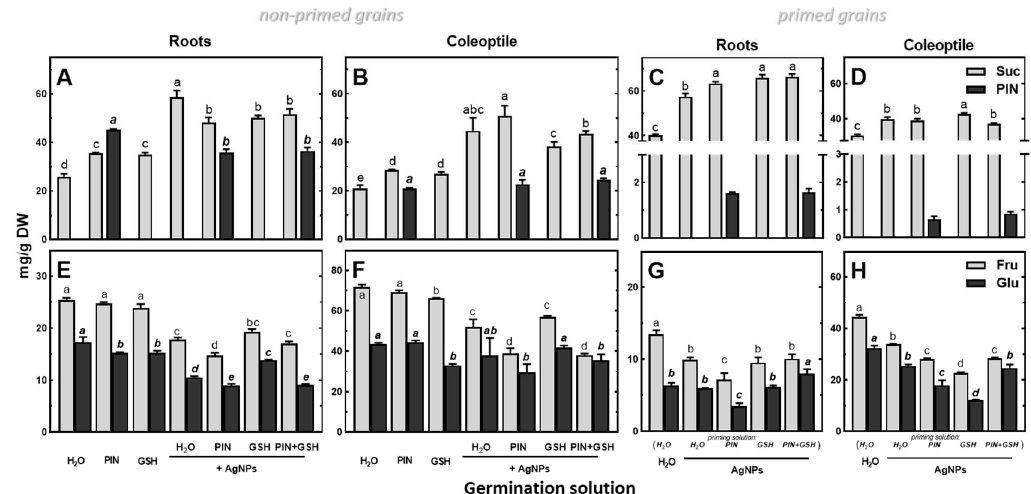
Figure 9. The effects of PIN (50 mM), GSH (12.5 mg/L), (Bio)Ag NPs (at 40 mg/L) and their mixtures on the concentrations of sucrose ( Suc ), D -pinitol (PIN), fructose ( Fru ) and glucose ( Glu ) in roots ( A , C , E , G ) and coleoptiles ( B , D , F , H ) in 3-day-old seedlings of wheat ( Triticum aestivum L. cv. Collada) obtained from non-primed ( A , B , E , F ) and primed grains ( C , D , G , H ). Values are means ( n = 3) + SD. Bars with the same letters (a–e) were not significantly ( p < 0.05) different after ANOVA test and Tukey’s post hoc corrections.